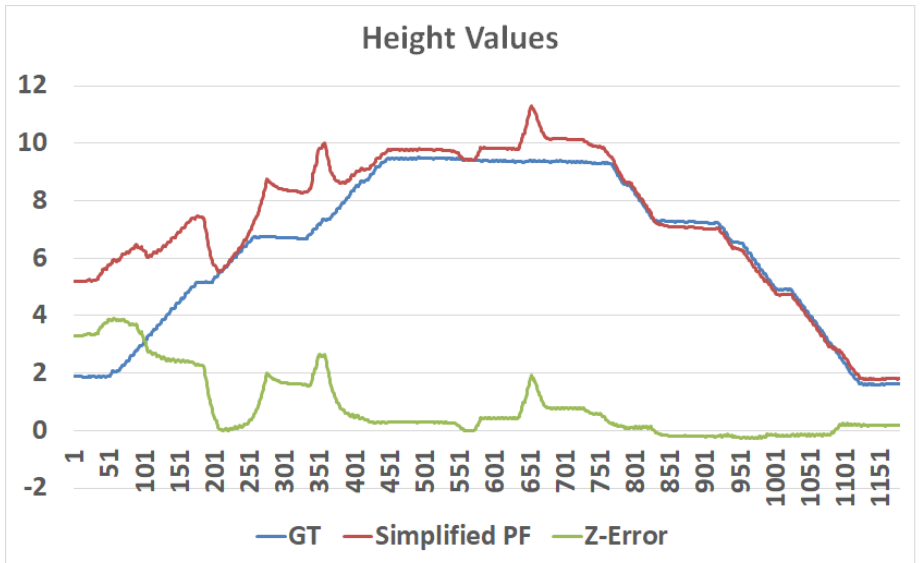
Figure 13. A 3 D particle filter in action: an (about) 120 s test, in which the position converged from an error of 3.5 m to a submeter within 40 s and to (about) 0.1 m error after 80 s. Note: the z value is defined according to the best particle height (no filter) in order to demonstrate the convergence process.